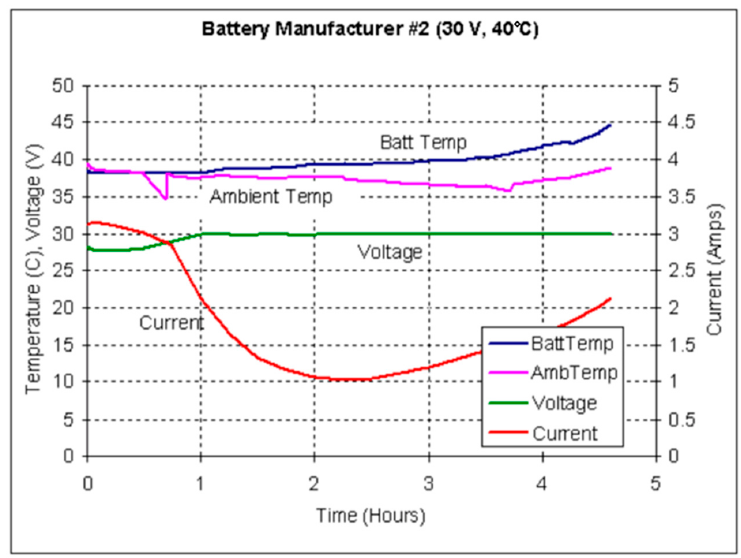
Figure 12. Graph showing the effects of thermal runaway on current and temperatures [61].